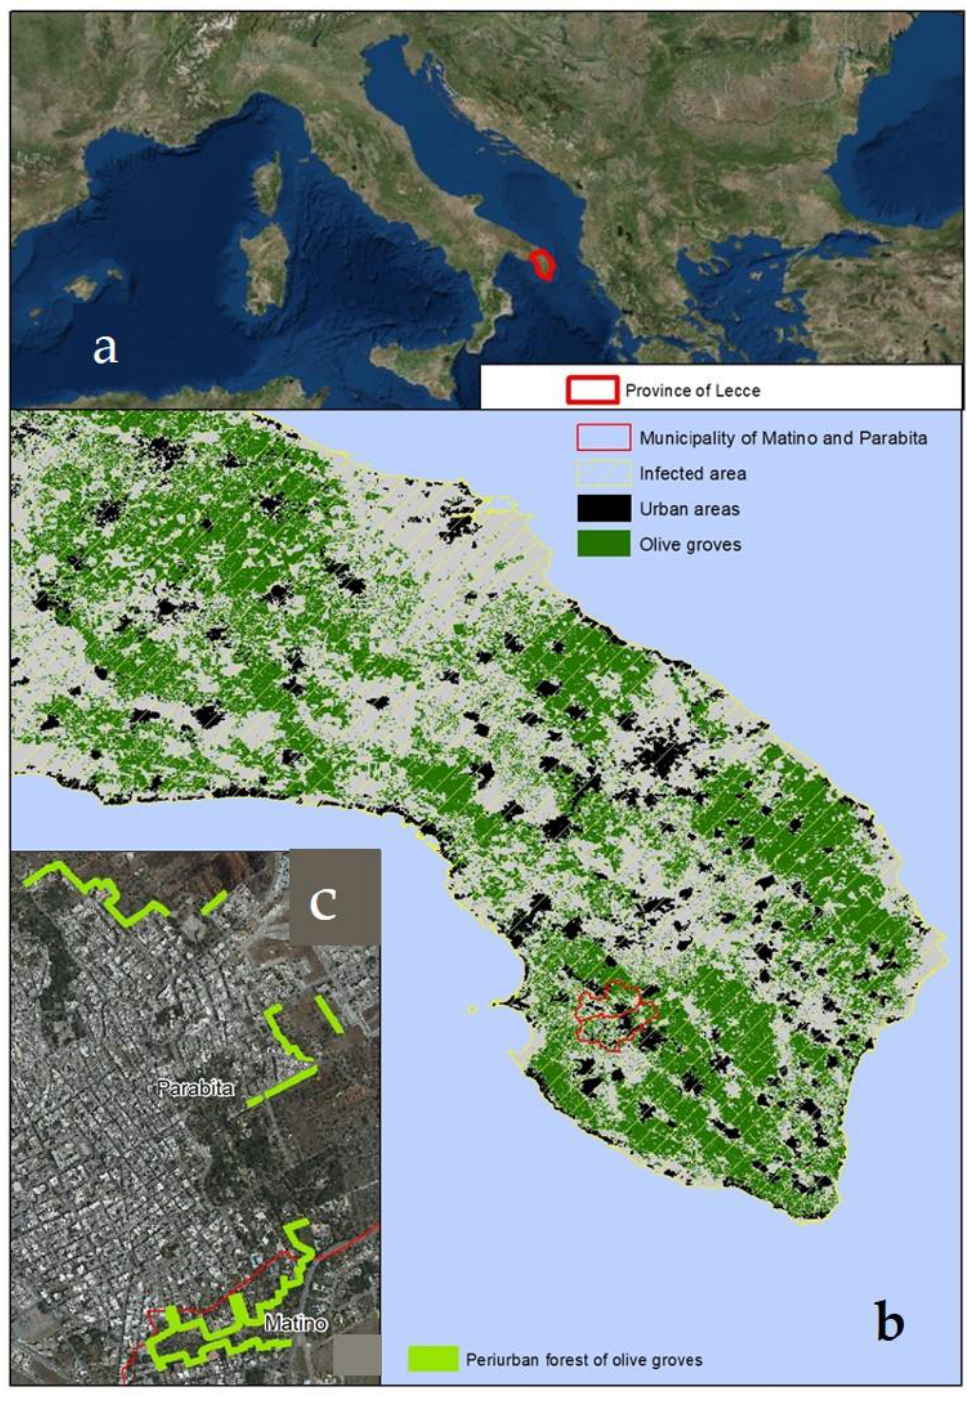
Figure 1. Study area: ( a ) The Province of Lecce in south Apulia; ( b ) the municipalities of Apulia region are characterized by a core urban mainly surrounded by olive groves, the latter currently strongly affected by X. fastidiosa , ( c ) the two selected peri-urban neighborhoods characterized by olive groves in the municipalities of Parabita and Matino. In the first case (municipality of Parabita) the olive groves surround the portion of the urban area, in the second case (municipality of Matino) the olive groves penetrate into the urban area.